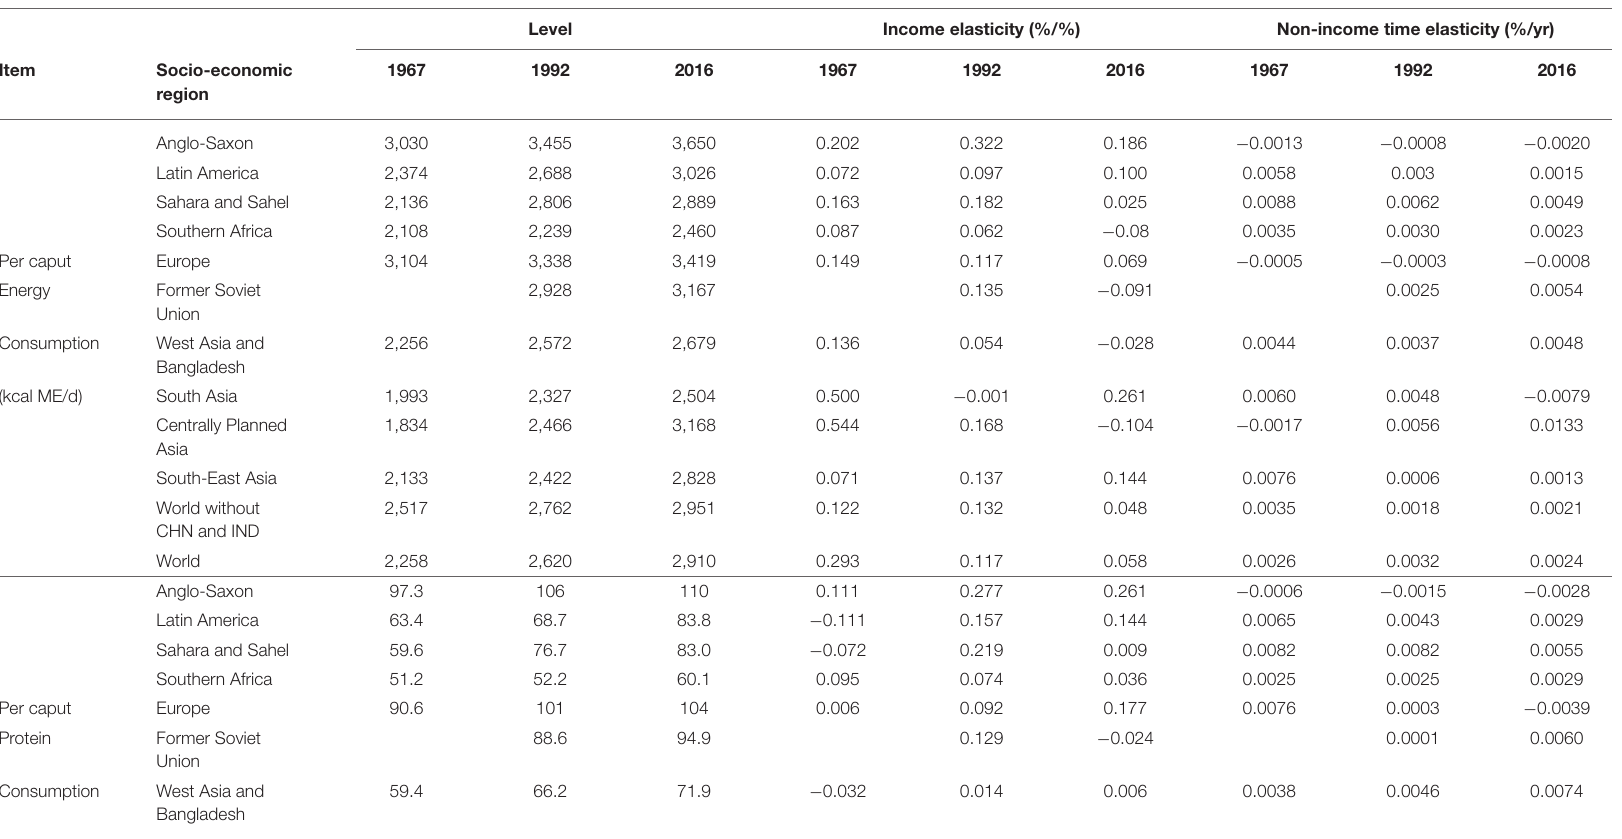
TABLE 2 | Time trends of energy and protein consumption and of the contribution made to these by animal source food (ASF), and of their estimated income elasticities ( β ) and non-income time elasticities ( γ ). CHN: China, IND: